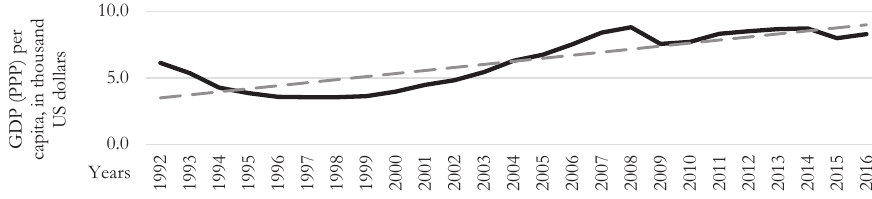
Fig. 9 – Historical and current trends of GDP (PPP) per capita growth in Ukraine. Source: IMF (2018)